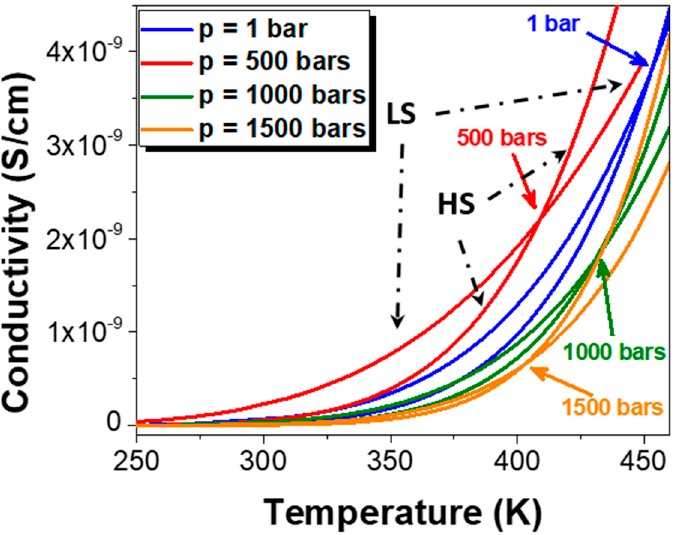
Figure 3. Temperature dependence of the electrical conductivity of sample S1 in the HS and LS states for di ff erent applied pressures, simulated using the activation parameters in Table 1.